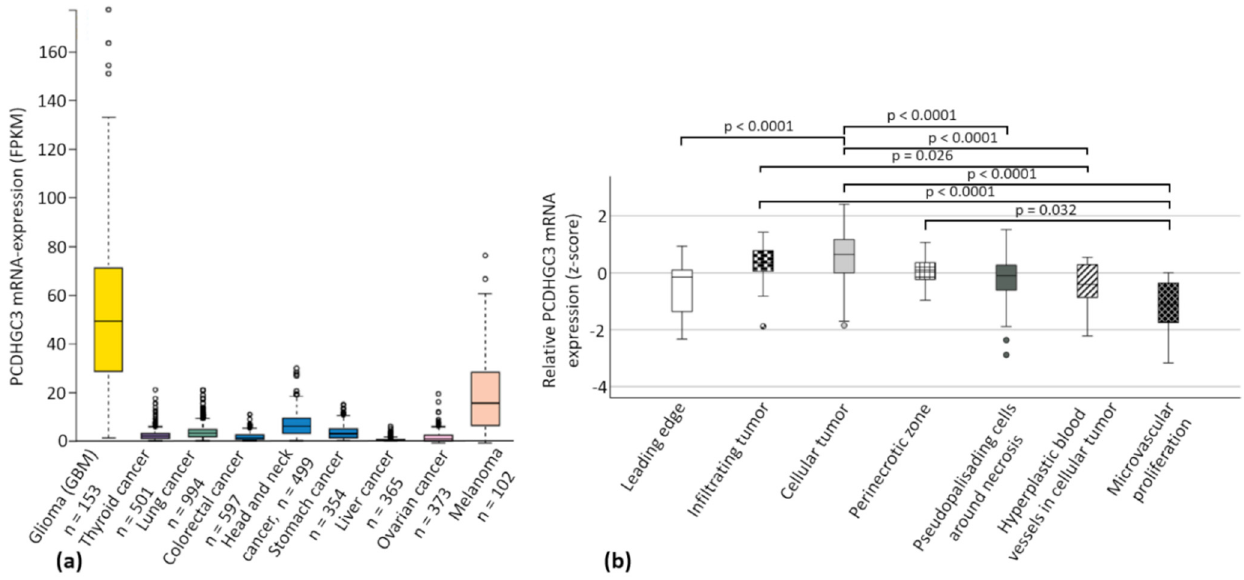
Figure 1. PCDHGC3 mRNA expression in different tumor entities and regions of GBM. ( a ) Different tumor types of the TCGA database were screened for PCDHGC3 mRNA expression (modified from The Cancer Genome Atlas 2020, National Cancer Institute). FPKM = Fragments Per Kilobase of transcript per Million mapped reads. ( b ) PCDHGC3 mRNA expression was compared in different areas of GBM by analyzing the Ivy Gap Dataset [25]. Different areas included leading edge ( n = 19), infiltrating tumor ( n = 24), cellular tumor ( n = 111), perinecrotic zone ( n = 26), pseudopalisading cells around necrosis ( n = 40), hyperplastic blood vessels in cellular tumor ( n = 22), and microvascular proliferation areas ( n = 14). Kruskal–Wallis test, post-hoc: Dunn’s test, correction of the significance according to Bonferroni. Circles mark statistical outliers.